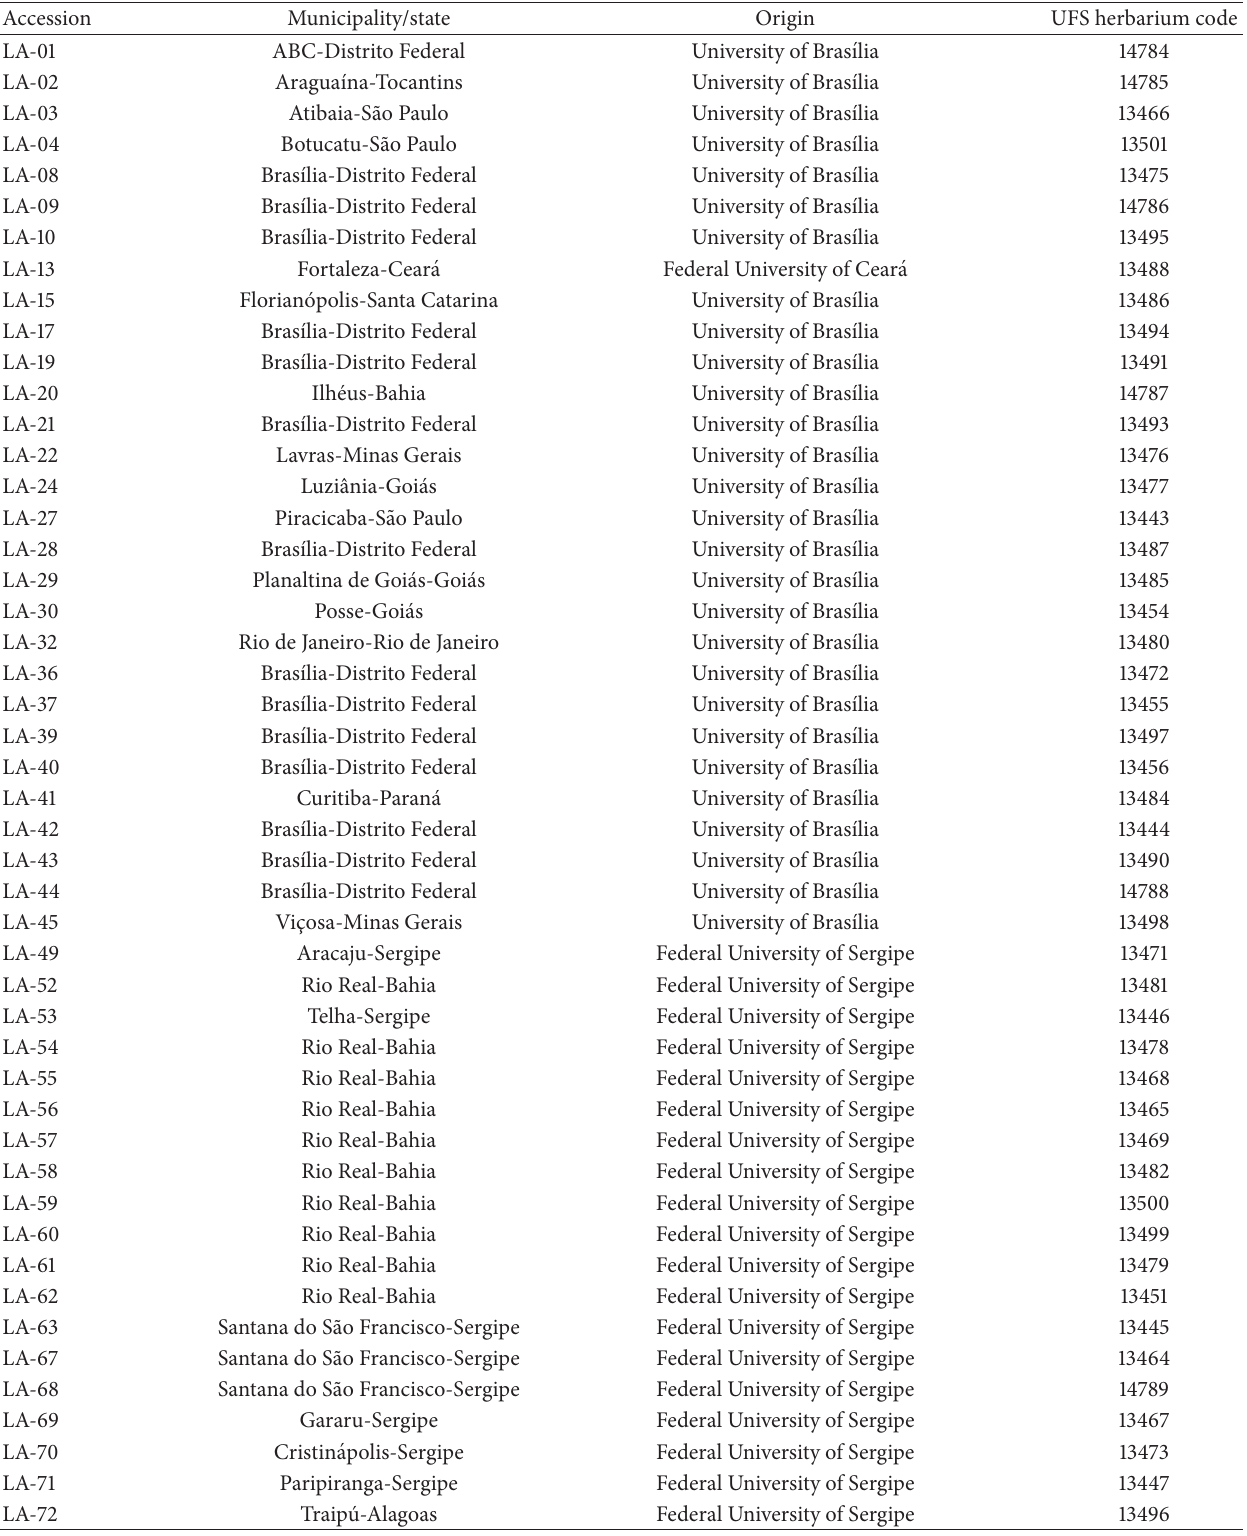
Table 1: Identification and origin of L. alba accessions from the Active Germplasm Bank at the Federal University of